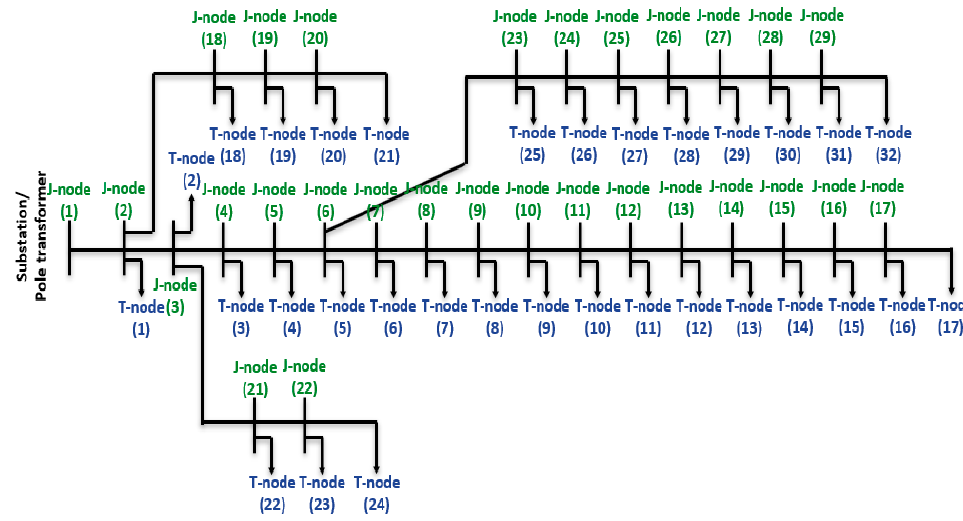
Figure 10. A typical IEEE 33-bus distribution network topology.